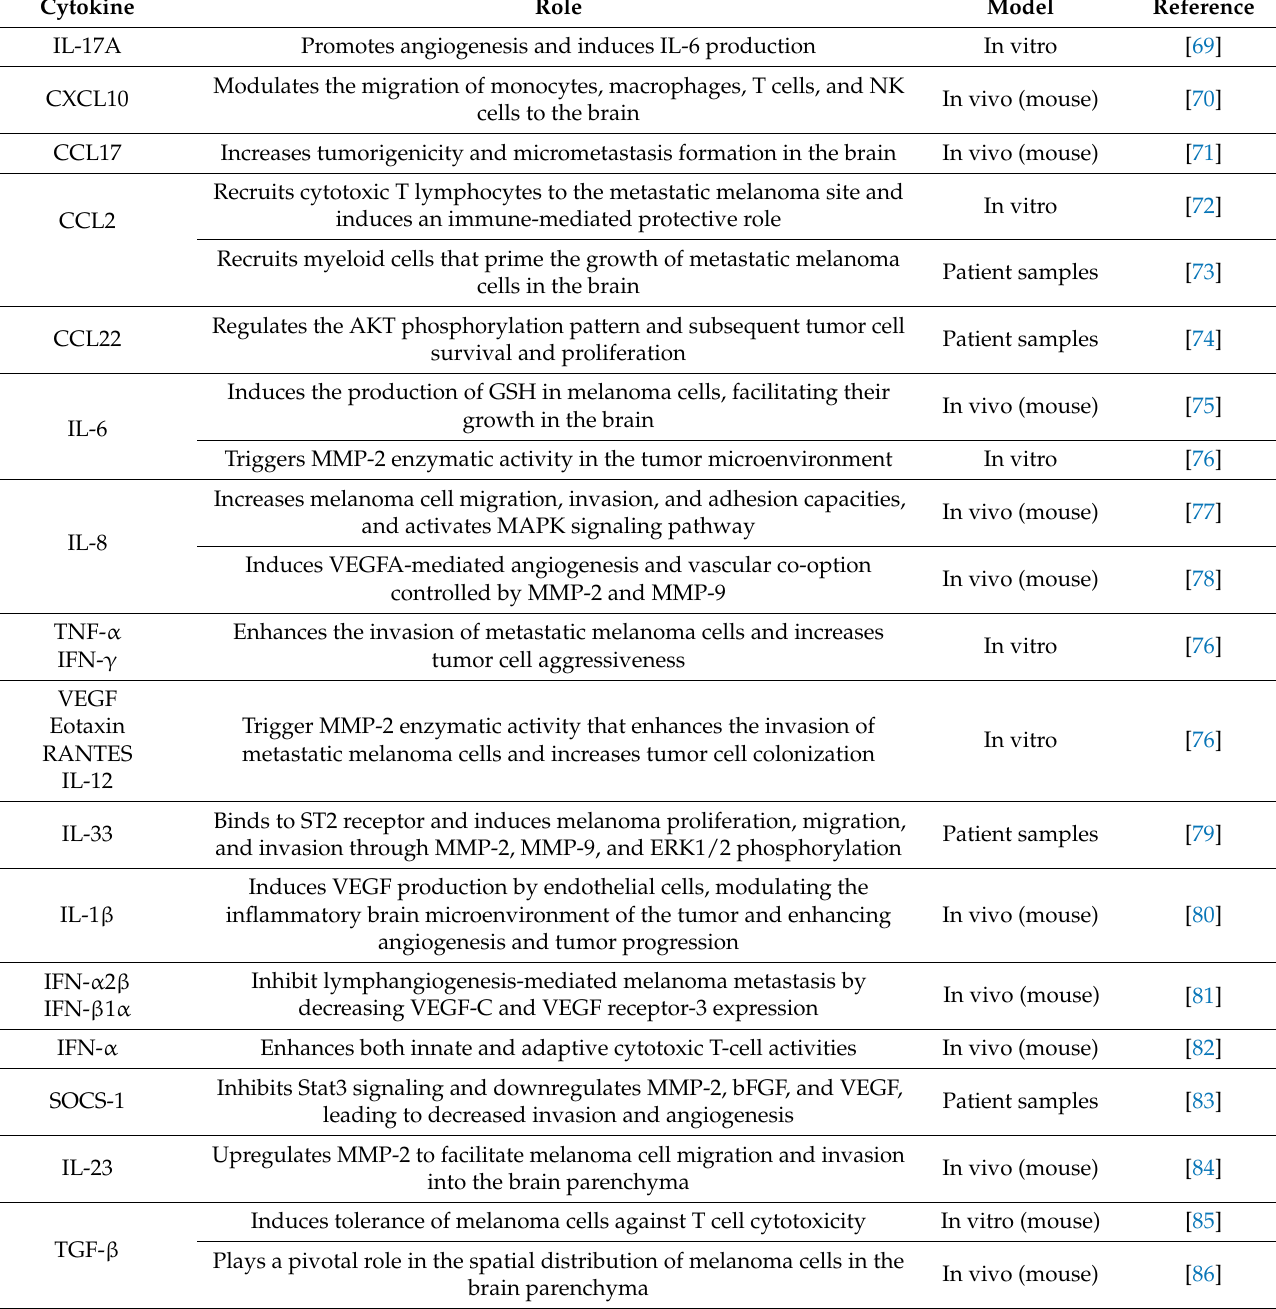
Table 3. Cytokines reported to have a role in melanoma brain